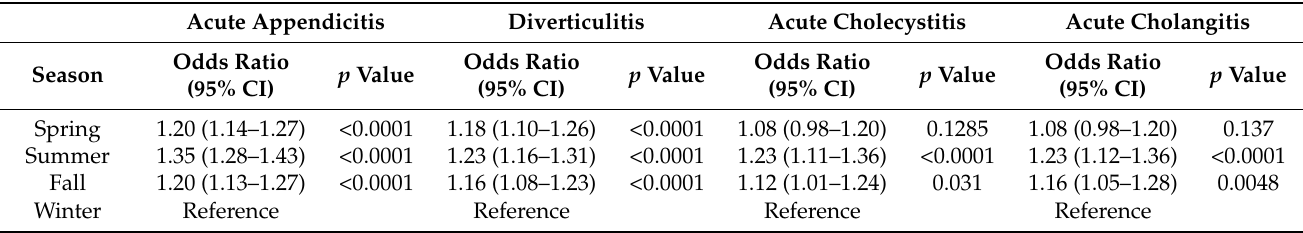
Table 3. Analysis of the seasonal admissions for each diagnosis.